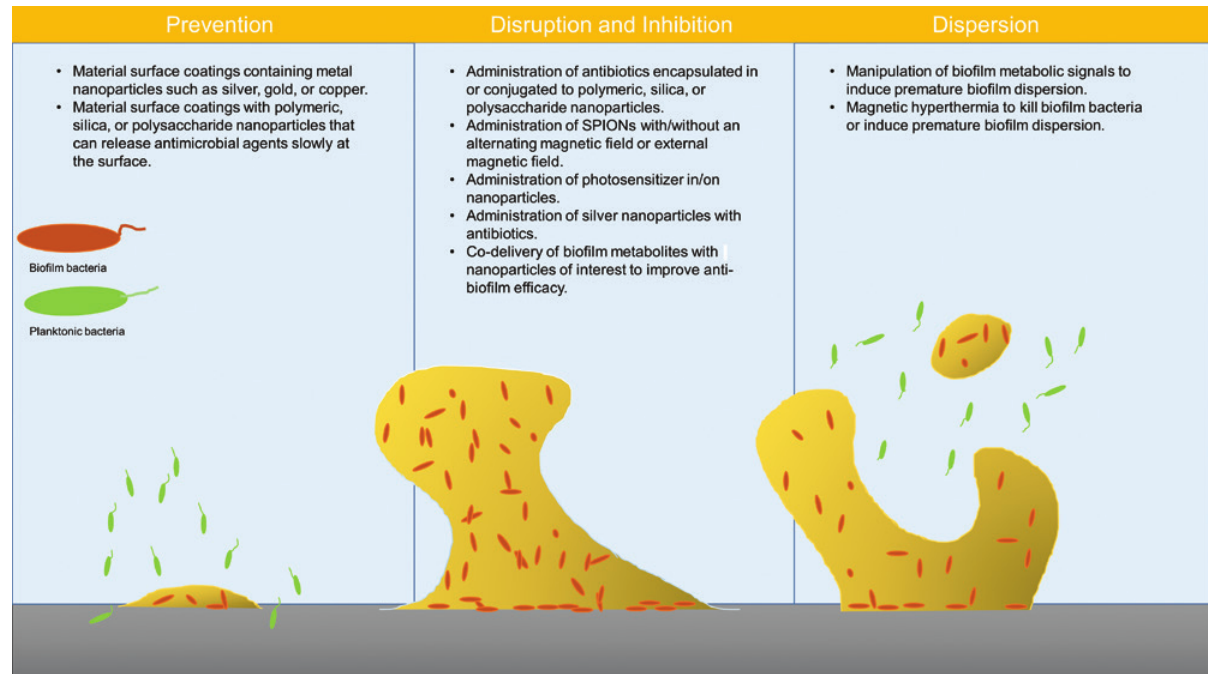
Figure 1: Applications of various nanoparticle treatments to either prevent, disrupt and inhibit, or disperse bacteria from biofilm